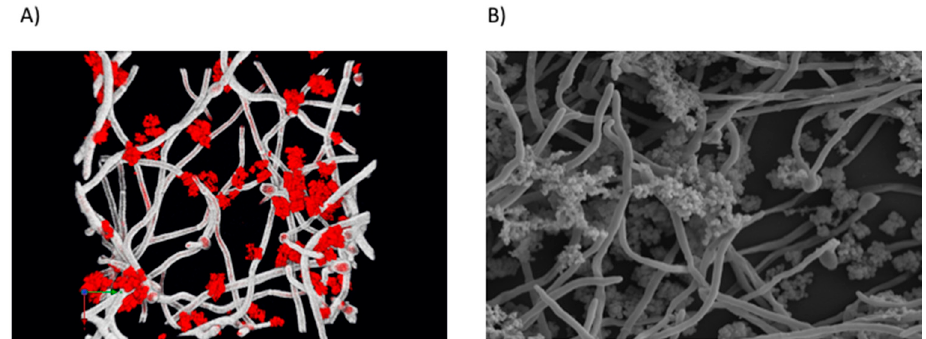
Figure 3. Candida albicans and Staphylococcus aureus dual-species biofilm. Confocal laser scanning micrograph (CLSM) ( A ) and scanning electron micrograph (SEM) ( B ) highlighting the close interaction between the bacteria (red) and fungal hyphae (white). The C. albicans mycofilm acts as a scaffold for S. aureus colonisation and biofilm formation. Images are viewed at × 2000 magnification.